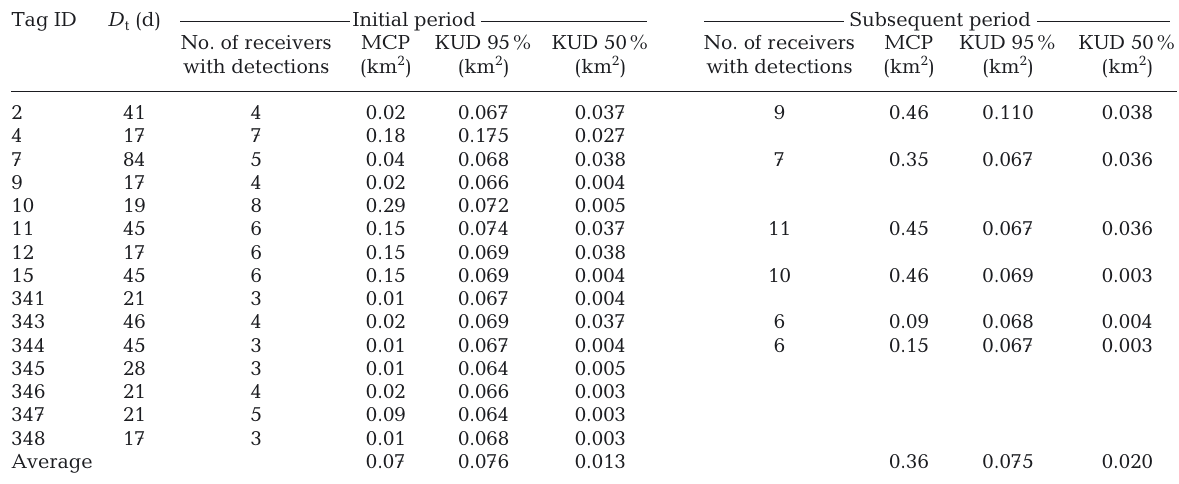
Table 2. The 15 tagged Sparus aurata recorded within the study array for >2 wk. Initial period includes first 2 wk post-release for each fish detected, while subsequent period includes time after the 2nd week till end of detection for each fish recorded for >1 mo within the study array. D t : number of monitoring days; MCP: minimum convex polygon based on 100% of the positions; 95% KUD and 50% KUD: kernel utilization distribution based on 95% and 50% of the positions respectively. For